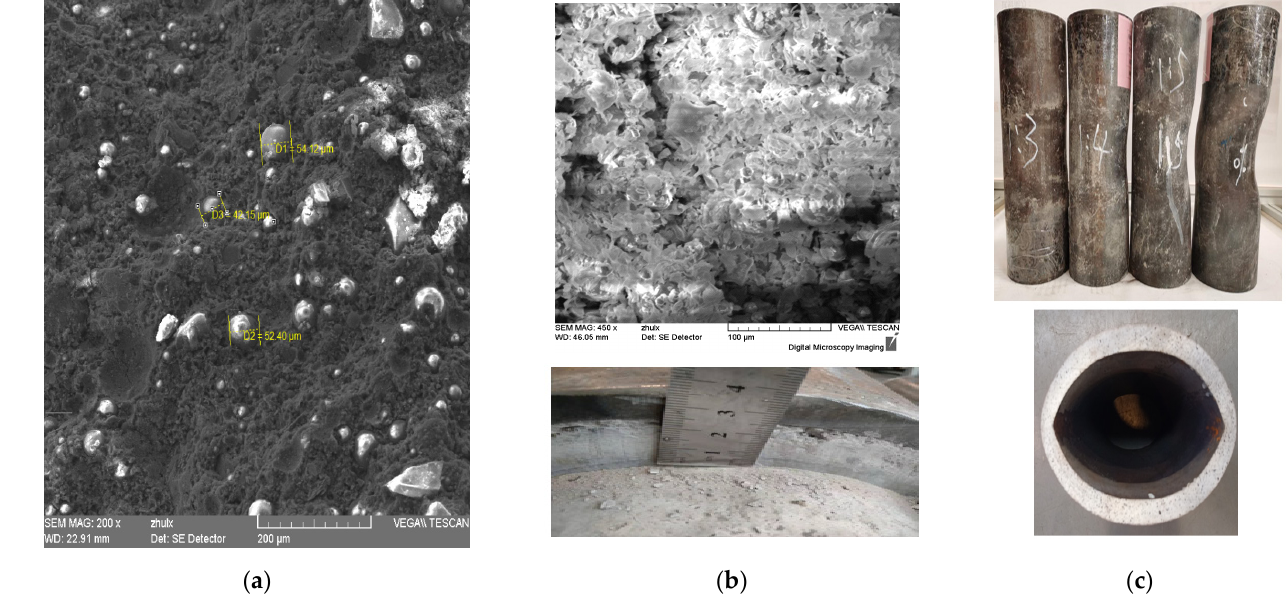
Figure 19. Modification results of cement sheath: ( a ) morphology of original hollow particles: “D1”, “D2”, “D3” are diameters of three particles; ( b ) particle crushing morphology; ( c ) casing deformation relief morphology.